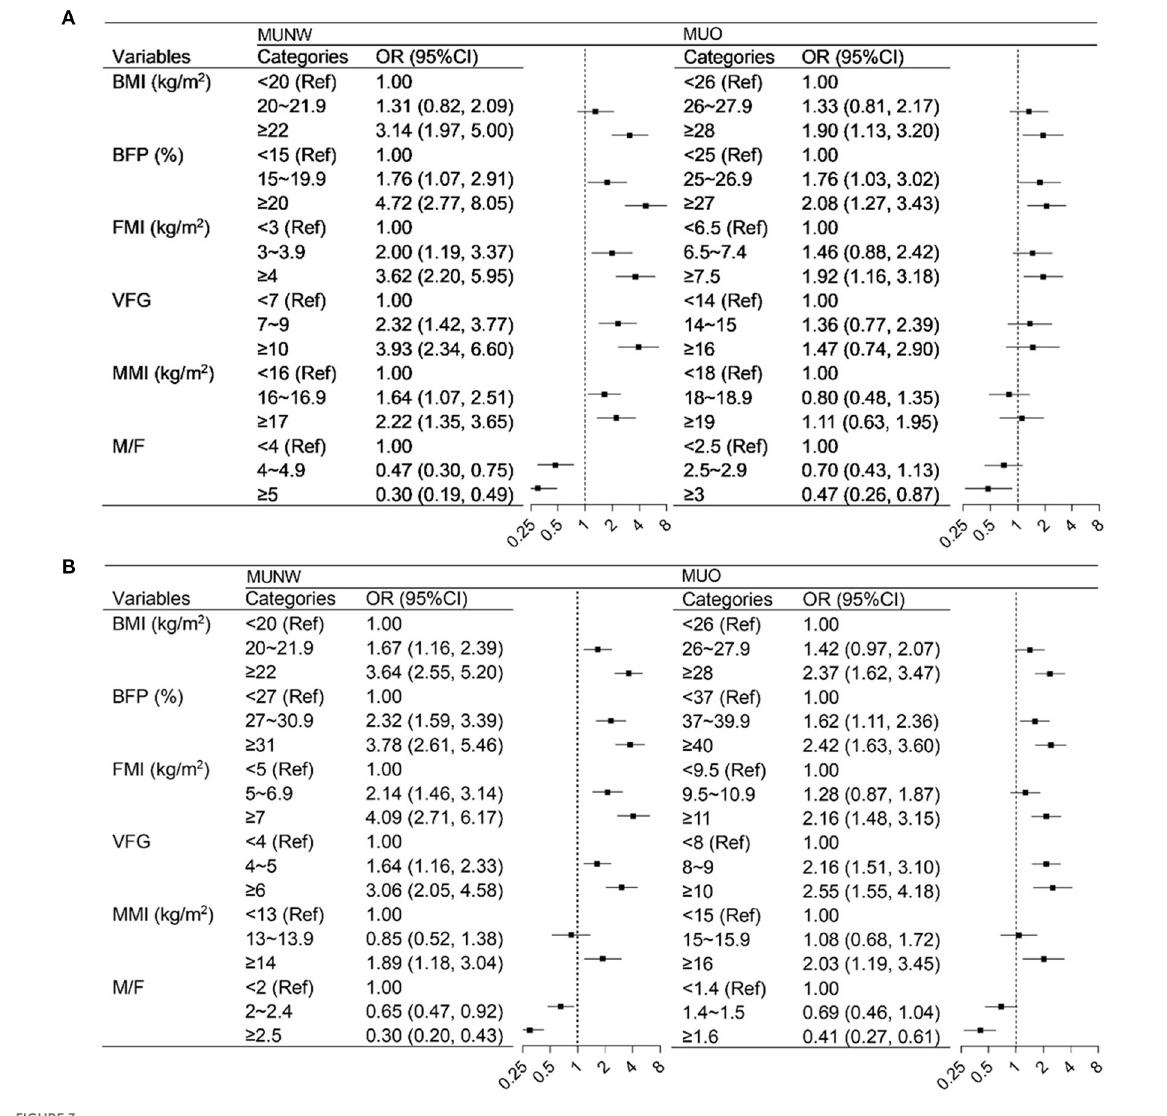
FIGURE3 Logistics regression analysis of the association between body composition with metabolically unhealthy phenotype by sex and BMI. (A) men, (B) women. BMI, body mass index; BFP, body fat percentage; FMI, fat mass index; VFG, visceral fat grade; MMI, muscle mass index; M/F, muscle-to-fat ratio. In the MUNW models, the MHNW was the control, and in the MUO models, the MHO was the control. Models were adjusted for age, residence, education, income, smoking status, drinking status, occupational physical activity, and leisure-time